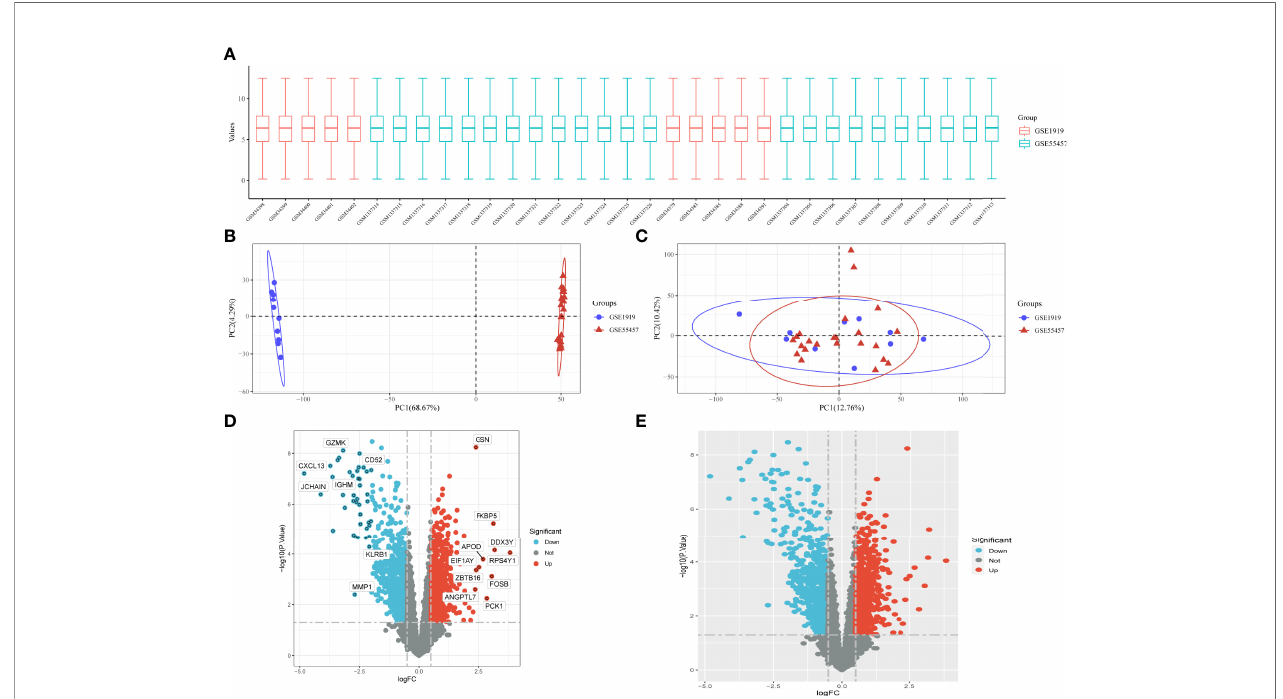
FIGURE 1 | Data preprocessing for DEG. (A) Box plots of raw data normalized between samples. (B, C) PCA of RA and control samples. (D) Volcano plot of DEG. (E) Heat map of